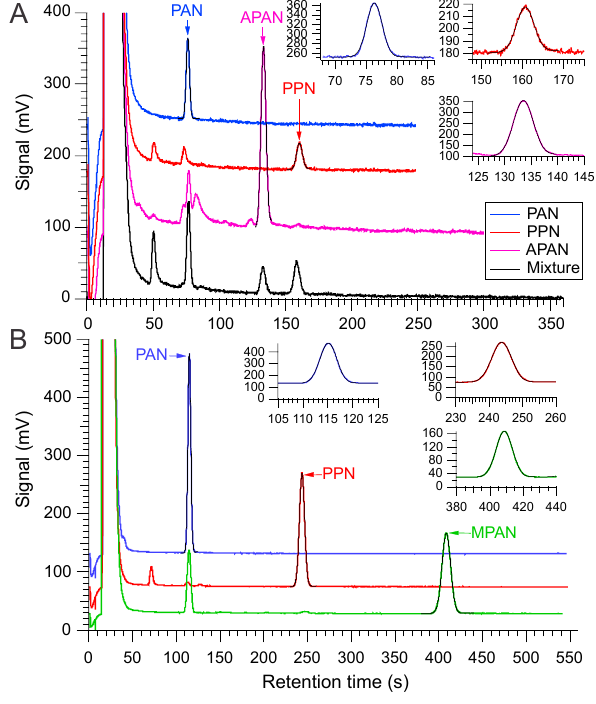
Figure 5. Sample chromatograms (vertically offset for clarity) of PAN, PPN, APAN, and MPAN standards on a 10.4m RTX-1701 column at a He flow rate of 20mLmin − 1 . (a) Chromatograms of standards acquired in the laboratory at a column oven temperature of 27 ◦ C. (b) Chromatograms of standards acquired during the FOS- SILS 2013 field study at an oven temperature of 22 ◦ C. The fits of expression (1) to the observed peaks are superimposed as black